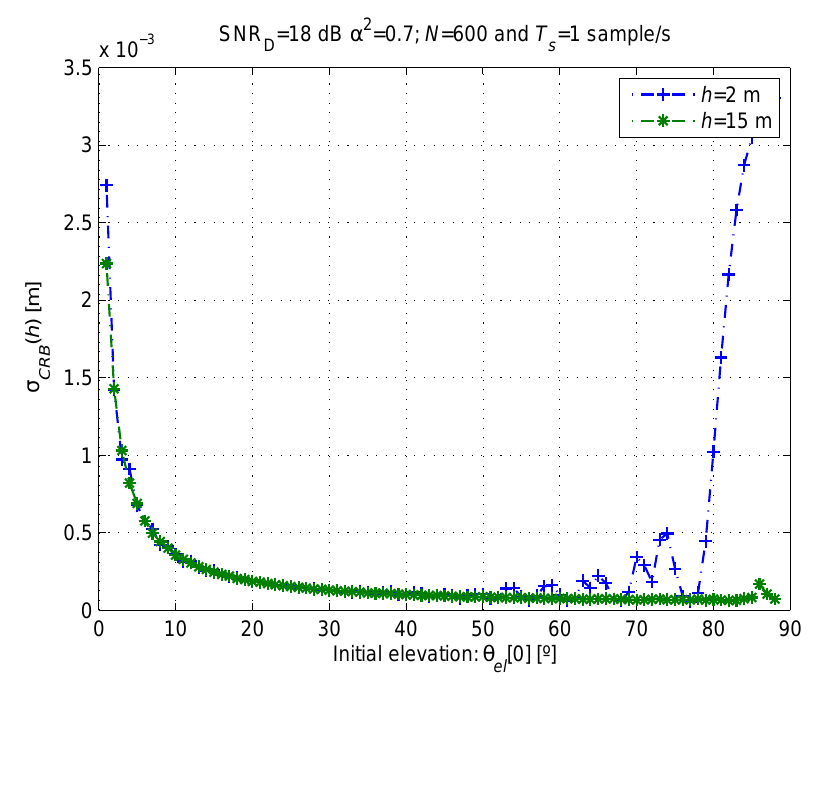
Figure 4. Cramér–Rao lower bound (CRLB) for different initial satellite elevation angles and receiver